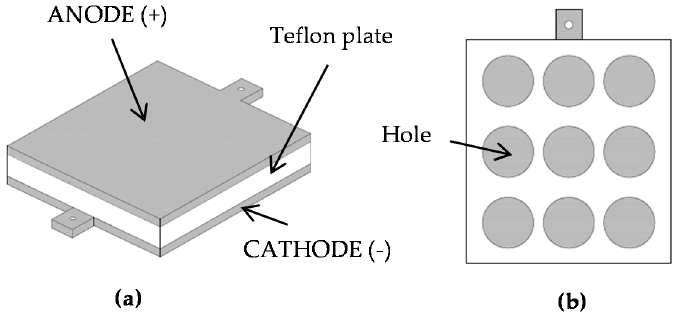
Figure 1. Schematic of the experimental set-up employed for the DC treatment of hydrosols and hydrogels; ( a ) side view, ( b ) cross-section.